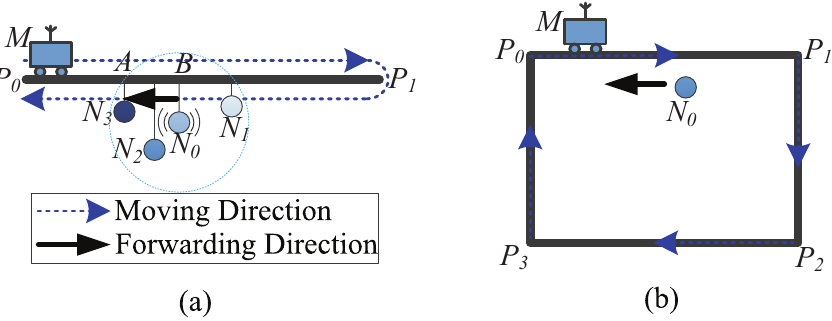
Figure 6. Examples of determining the forwarding directions for ( a ) the round-trip path; and ( b ) the cyclic